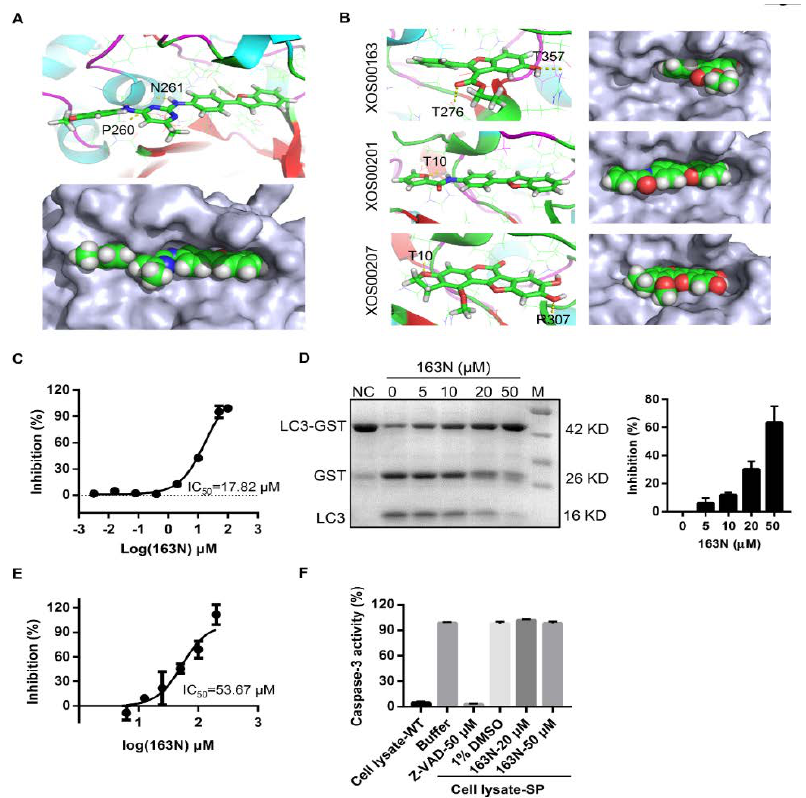
Figure 2. 163N inhibits the activity of ATG4B. ( A ) Predicted binding model of compound 163N binds to ATG4B (Protein Data Bank (PDB) ID: 2CY7) pocket. 163N can form hydrogen bonds with residues Pro260 and Asn261 of ATG4B (yellow dotted lines). ( B ) Predicted binding model of compound XOS00163, XOS00201, and XOS00207 bind to ATG4B (PDB ID: 2CY7) pocket. ( C ) IC50 calculation of 163N for ATG4B from fitted curve by fluorescence resonance energy transfer (FRET) assay. ( D ) ATG4B (1 µg/mL) was incubated with different concentrations of 163N (5, 10, 20, 50 µM) at 37 ° for 30 min, then LC3B-GST was added to the mixture and incubated at 37 °for another 30 min. SDS-PAGE was used to detect the inhibitory effect of 163N. The inhibition rate (%) was calculated based on the band density and quantified. Data are presented as mean ± SEM from three individual experiments. ( E ) Measurement of the IC50 of 163N for ATG4A by FRET assay. ( F ) Measurement of the specificity of 163N against other cysteine proteases. HeLa cells were treated with 1 µM of staurosporine (SP) for 12 h to induce cell apoptosis. Then, 2 µg of the whole cell lysate were mixed with indicated compounds at 37 ° for 30 min, Ac-DEVE-AFC (25 µM) were then added to a volume of 50 µL, and the emission of 505 nm for AFC was recorded. 2.3. 163N Suppresses Autophagy Flux To identify the impact of 163N on autophagy, A549 cells stably expressing GFP-LC3 were used. We found that 163N caused the accumulation of GFP-LC3 dots in dose- and time-dependent manners (Figure 3A). We then examined the effect of 163N on LC3 conversion in both HeLa and HCT116 cells, western blot analysis showed that 163N treatment resulted in dose- and time-dependent accumulation of LC3-II in both cell lines (Figures 3C,D and S2A,B). However, similar to Earle’s Balanced Salt Solution (EBSS) treated cells, 163N treatment did not induce LC3-II in ATG5-deficient cells (Figure 3B), an indication that 163N-induced LC3-II was autophagy-dependent. To confirm the effect of 163N on autophagy, two autophagy inhibitors CQ and Baf were used to measure LC3-II turnover. Western blot analysis showed that 163N treatment did not further enhance the expression level of LC3-II induced by CQ or Baf groups (Figure 3E), therefore, 163N treatment may inhibit autophagy flux. An autophagy flux analysis in GFP-LC3 A549 cells was consistent with the western blot analysis (Figure S2C). In addition, in contrast to the EBSS treated cells, 163N significantly